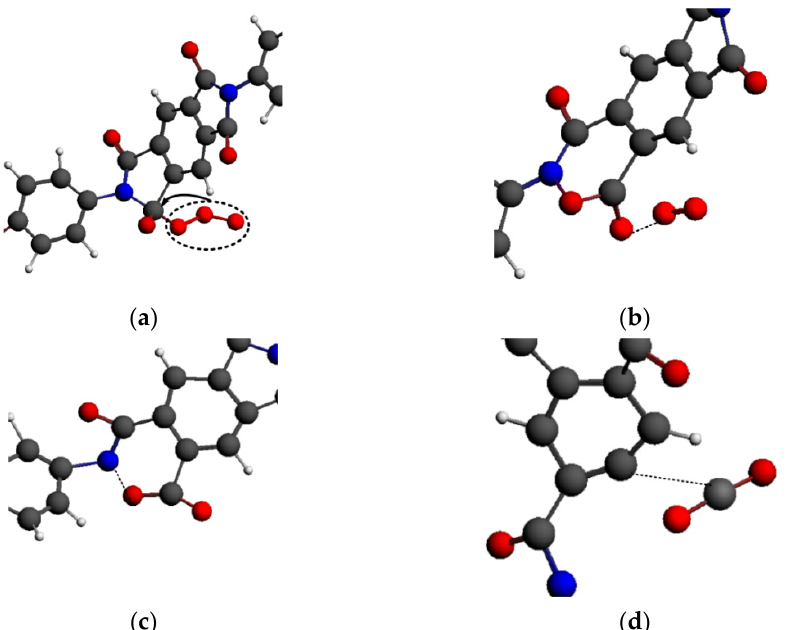
Figure 19. Functional mechanism of ∙ O 3 . ( a ) ∙ Oxygen adsorbed on the PI carbon atoms; ( b ) The exfoliation of oxygen molecules; ( c ) The breaking of nitrogen ‐ oxygen bond; ( d ) The exfoliation of CO 2 molecules from main chain.